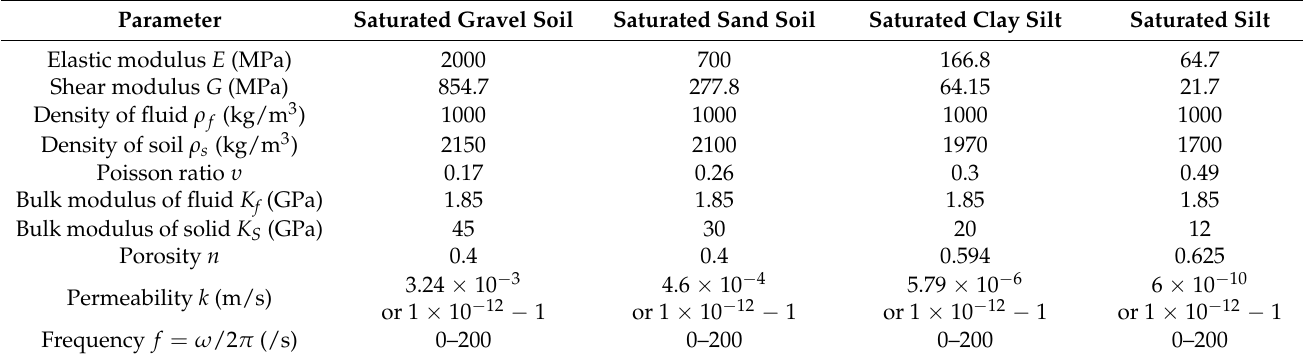
Table 2. Material parameters of four saturated